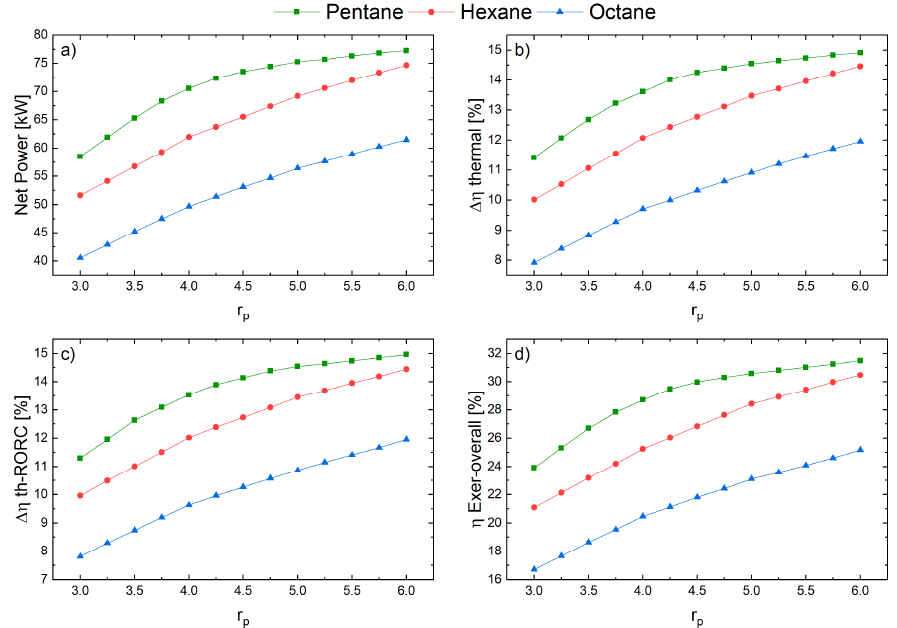
Figure 7. Performance of di ff erent fluids for a RORC system with varying pressure ratios. ( a ) Net power; ( b ) Increase in thermal e ffi ciency; ( c ) RORC thermal e ffi ciency; and ( d ) Global exergetic e ffi